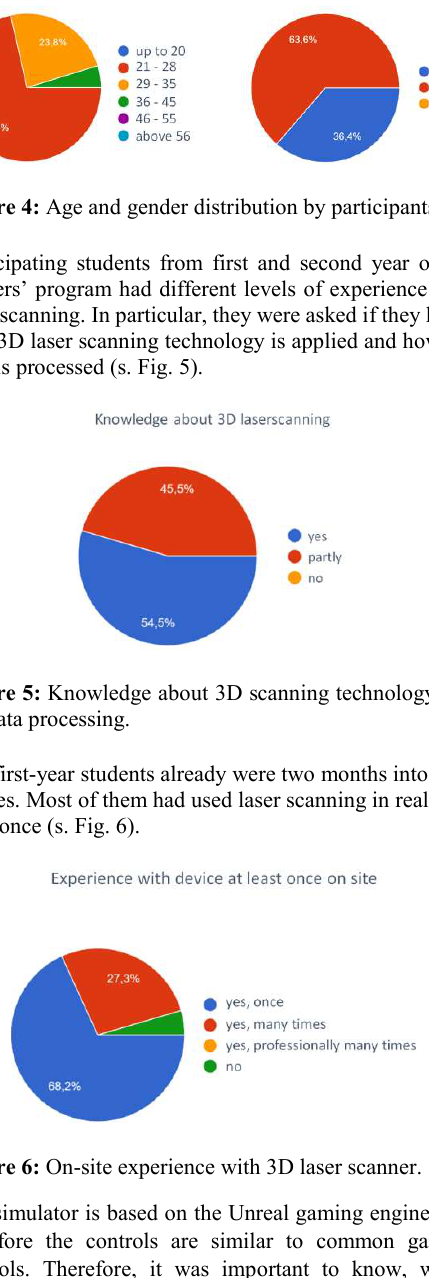
Figure 9: Evaluation of target and scanner